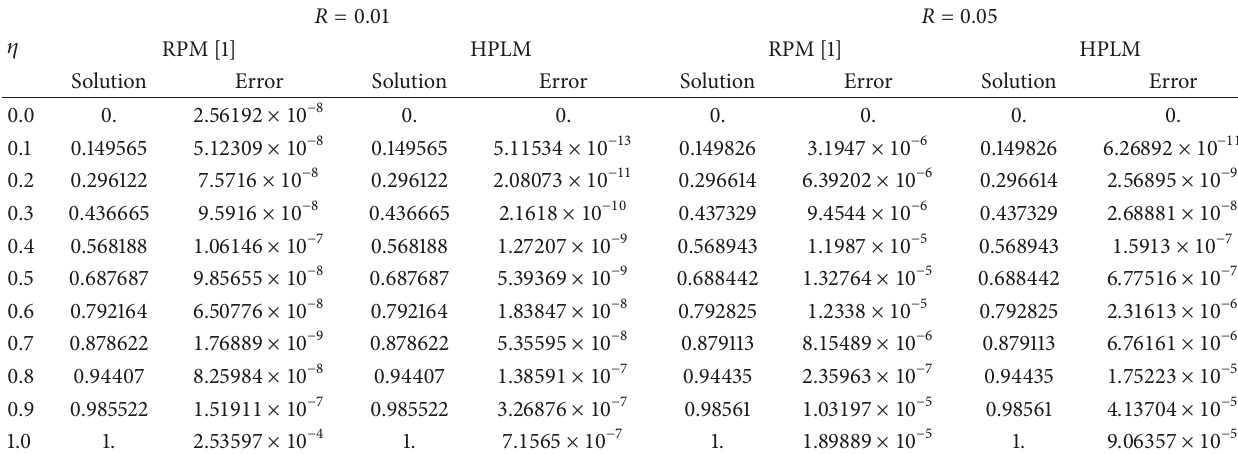
Table 4: Comparison of HPLM and RPM solutions along with absolute residual errors for various 𝑅 .